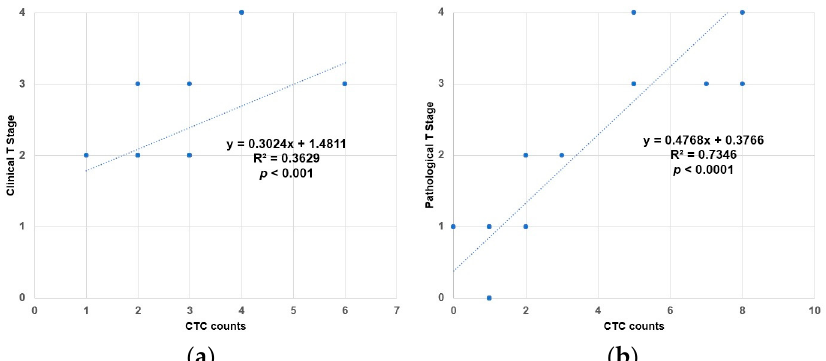
Figure 3. Correlation of CTC values with cancer T stage. ( a ) Univariate regression analysis between baseline CTC number/7.5 mL and clinical T stage; ( b ) Univariate regression analysis between CTC number/7.5 mL after four cycles of NAC and post-operative pathological T stage.